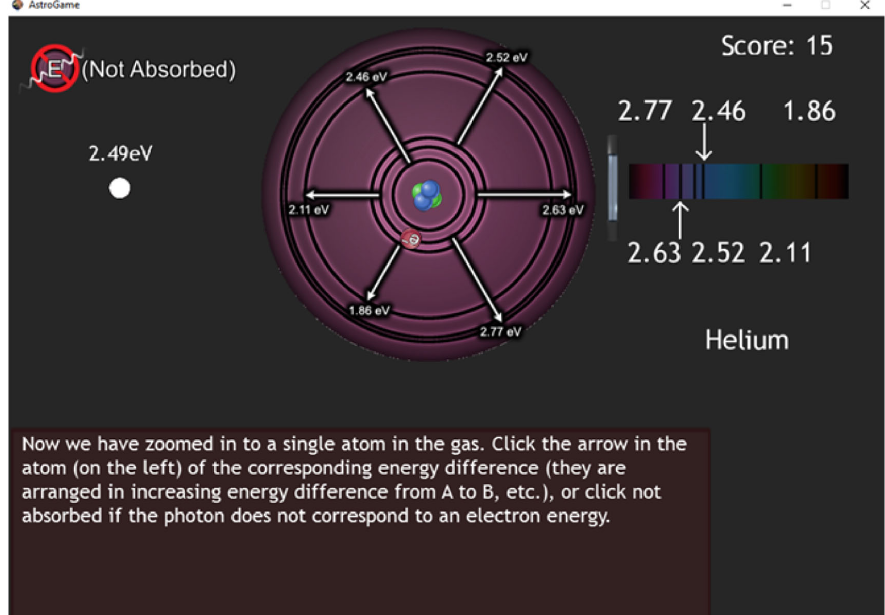
FIG. 4. Screenshot from the part of the Spectroscopy minigame where the students see how absorption (shown here) and emission occur on the scale of individual